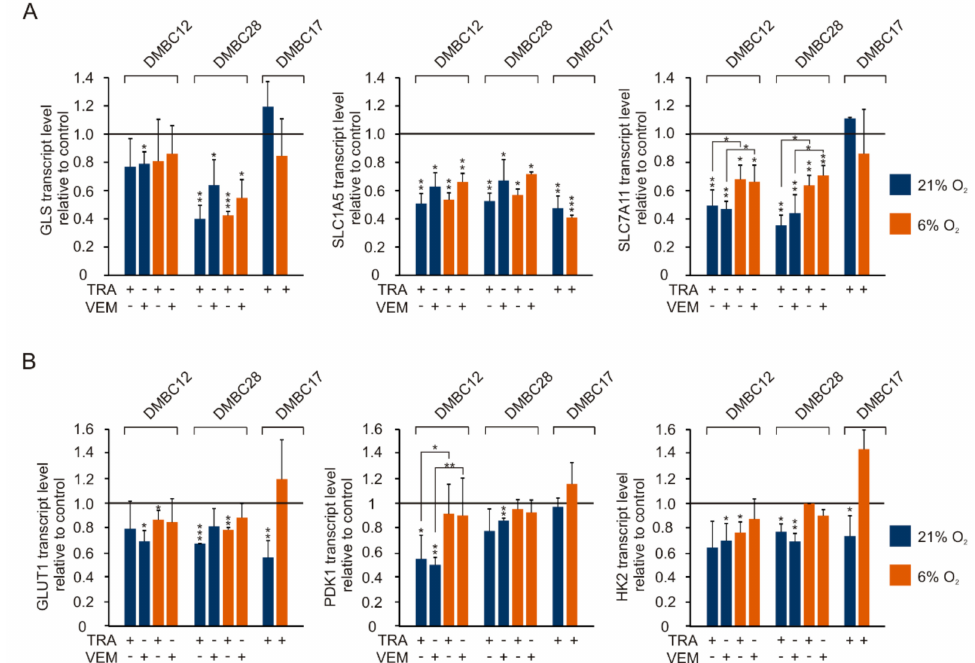
Figure 8. E ff ects of trametinib (TRA) and vemurafenib (VEM) on the expression of genes related to glutamine and glucose metabolism assessed at di ff erent oxygen concentrations. Drug-induced changes in transcript levels of glutamine ( A ) and glucose ( B ) metabolism-related genes after 24 h of treatment with either vemurafenib or trametinib. qRT-PCR data were normalized to the expression of a reference gene RPS17. Bars represent mean values of 3-4 biological replicates ± SD. Statistically significant di ff erences are indicated: * p < 0.05, ** p < 0.01 or *** p <